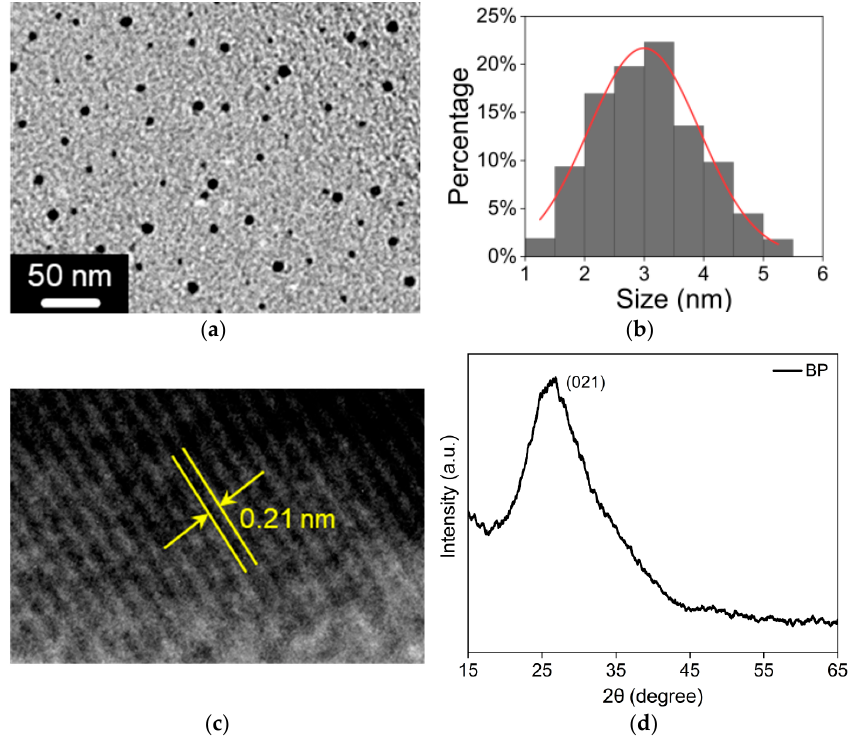
Figure 3. Microstructural properties of BP QDs in aqueous solution: ( a ) Morphology; ( b ) High-resolution lattice fringes; ( c ) Size distribution; ( d ) XRD pattern.